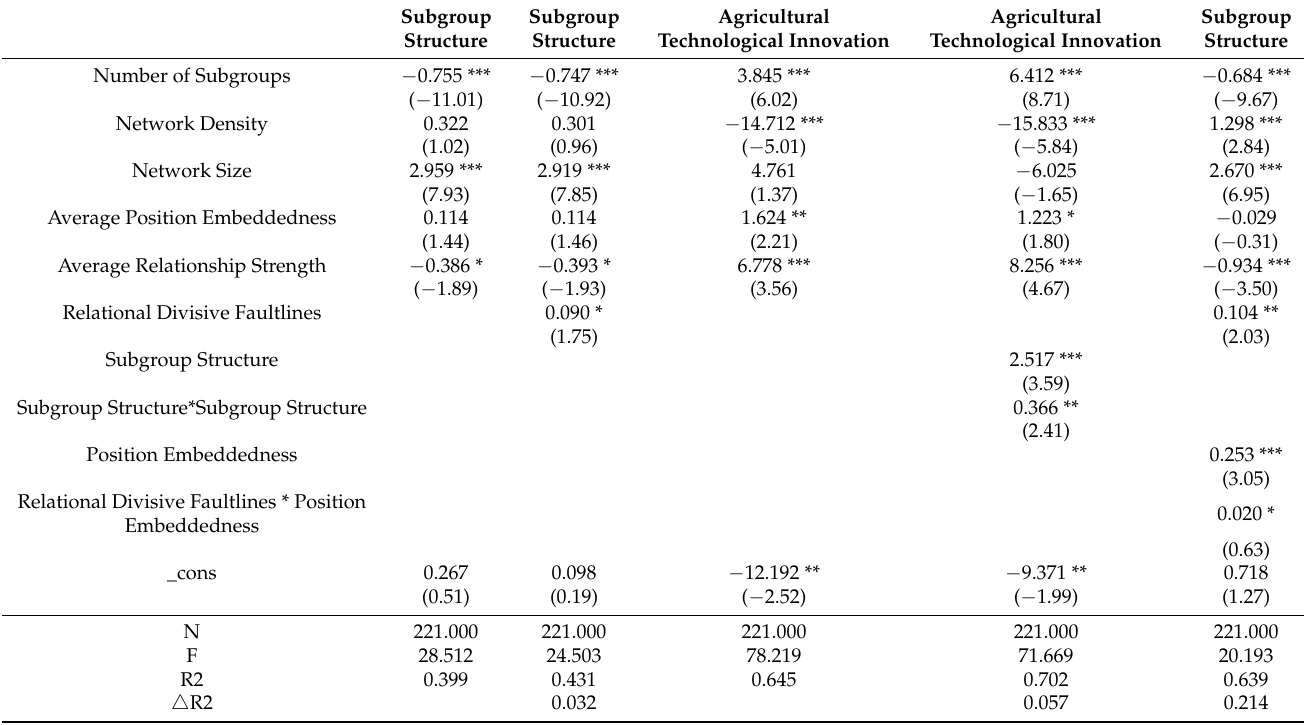
Table 5. The Results of Robustness Test after Changing the Indicators of Agricultural Technological